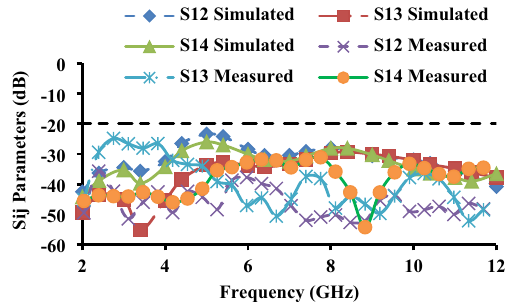
Figure 11. Measured and simulated S ij -parameters of the proposed